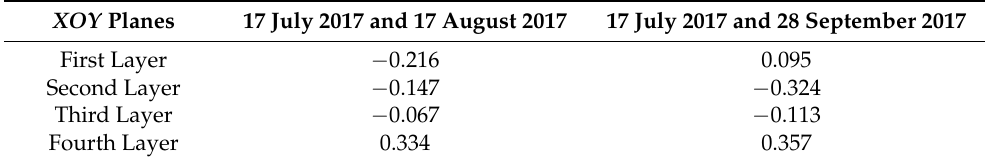
Figure 8. Temperature field cloud map of the second layer on the XOY plane on 17 August 2017. Table 7. The influence of new grain on the temperature correlation on the XOY plane.